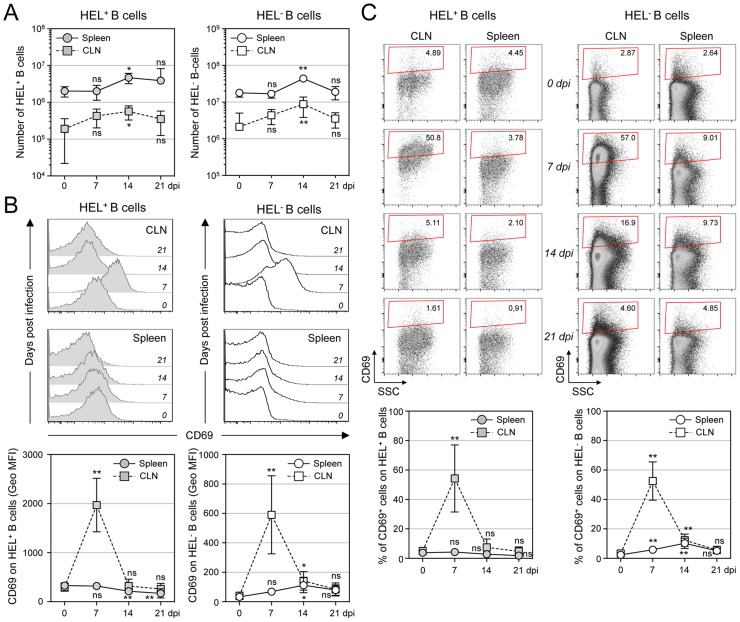
Proliferation and transient activation of total B cells.Spleens and CLN from YFP-MuHV-4 infected SWHEL mice were harvested at 0, 7, 14 and 21 dpi and cells were stained with CD69 PE, CD19 APC-Cy7 and HEL-A647. (A) Live cells were enumerated, and the number of HEL+ and HEL− B cells was established based on their frequency obtained from the FACS data. (B) Representative FACS histograms showing CD69 expression on HEL+ (grey curves) and HEL− (white curves) B cells isolated from CLN and spleen at the different time points are shown. CD69 was monitored by measuring the Geo MFI and compiled values are shown in the graphic below. (C) On the same samples, the frequency of CD69high cells was evaluated. Representative FACS plots are shown and compiled percentages are presented in the graphic below. These data were obtained from two independent experiments, with a total 5 to 6 mice per time point. In the graphics, mean values are reported and error bars represent the standard deviation.